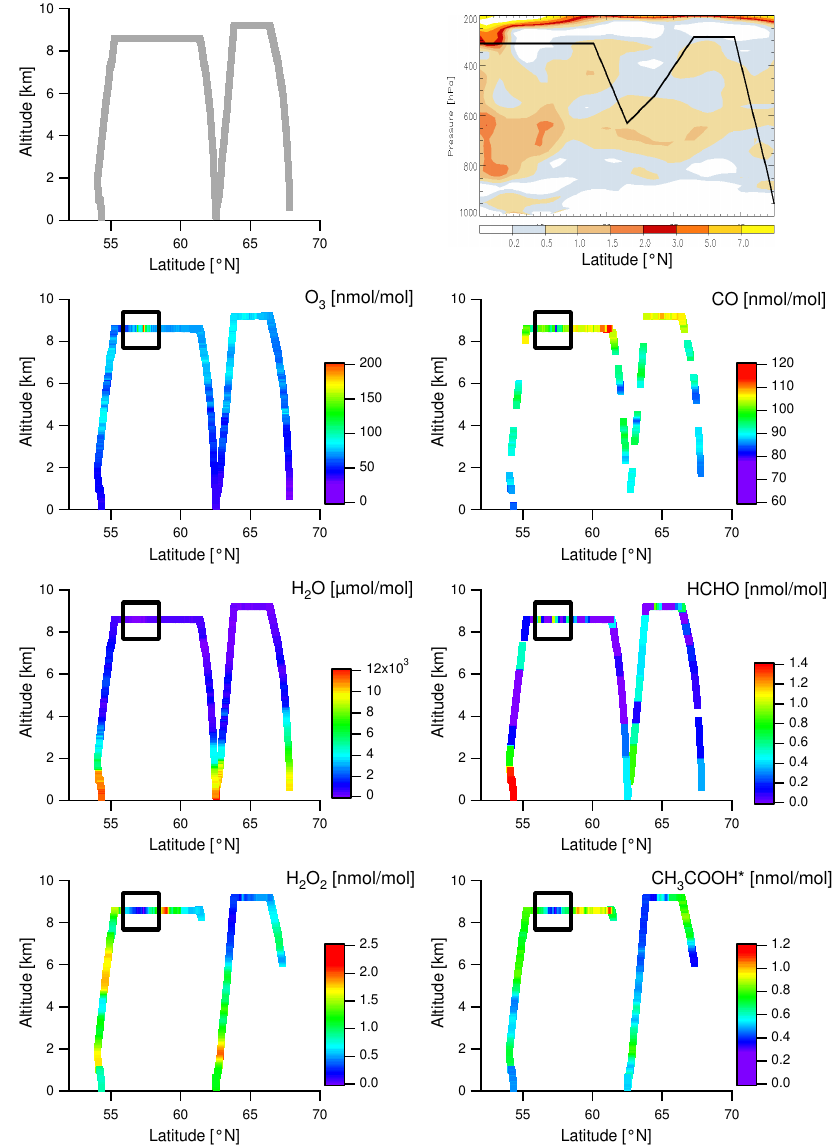
Fig. 2. Upper left corner: standard path of a HOOVER flight shown as altitude vs. latitude plot. Other figures show the mixing ratios of H 2 O 2 , CH 3 OOH ∗ , HCHO, O 3 , CO and H 2 O of HOOVER flight 10 as colour codes of the vertical profiles. The stratospheric influence during this flight can be seen in the black rectangle. Ozone values are >> 100 nmol/mol tend to be anticorrelated with CO. Both peroxides show very low values in this intrusion. Upper right corner: ECMWF simulated potential vorticity values for this flight as colour code with the flight track sketched only roughly as the black line (hence the deviation with the precise flight tracks in the other panels), providing supporting evidence for a stratospheric intrusion.